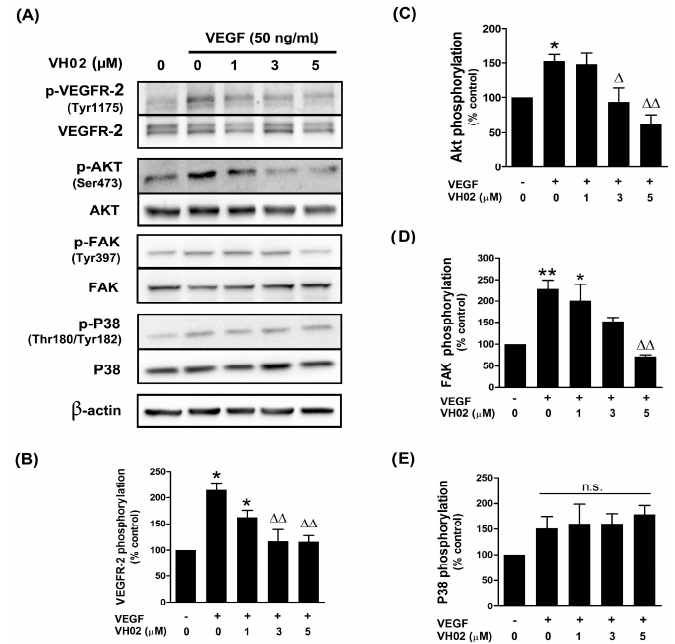
Figure 4. Effects of VH02 on VEGF-mediated signaling pathway through VEGFR2, Akt, FAK and P38 in EA.hy926 cells. The protein phosphorylation of VEGF receptor-2 (p-VEGFR2), Akt (p-Akt), FAK (p-FAK), and P38 (p-P38) was analyzed by western blot analysis as described in the Materials and Methods section. ( A ) Representative blots show protein phosphorylation signals relative to the non-phosphorylated proteins; ( B ) Changes in VEGFR2 phosphorylation; ( C ) Changes in Akt phosphorylation; ( D ) Changes in FAK phosphorylation; ( E ) Changes in P38 phosphorylation. Values were represented as mean ± SEM. * p < 0.05; ** p < 0.01 versus vehicle control; ∆ p < 0.05; ∆∆ p < 0.01; n.s. non-significant versus VEGF